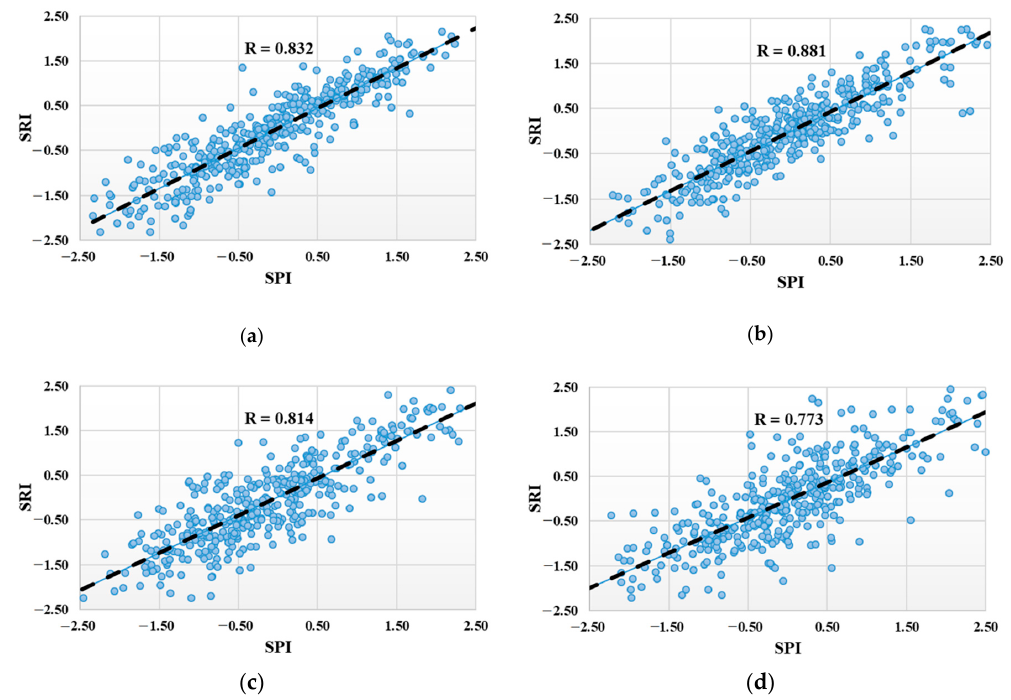
Figure 2. Relationship between the Standardized Precipitation Index (SPI) and Standardized Runo ff Index (SRI) in the selected sub-basins. ( a ) Sub-basin #1003, ( b ) Sub-basin #1010, ( c ) Sub-basin #1012, ( d ) Sub-basin #1018. #: